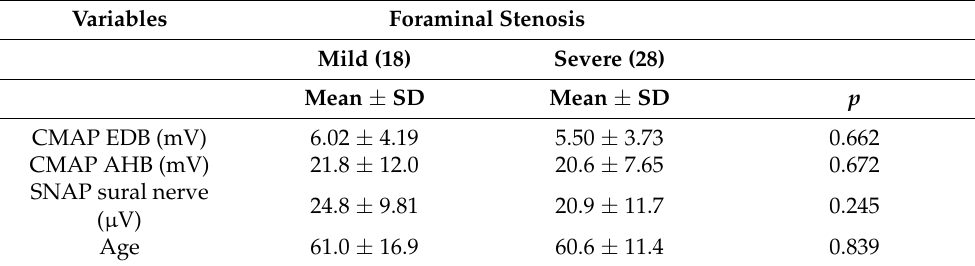
Table 2. The amplitude in the NCS on lower and age according to the severity of foraminal stenosis. Variables